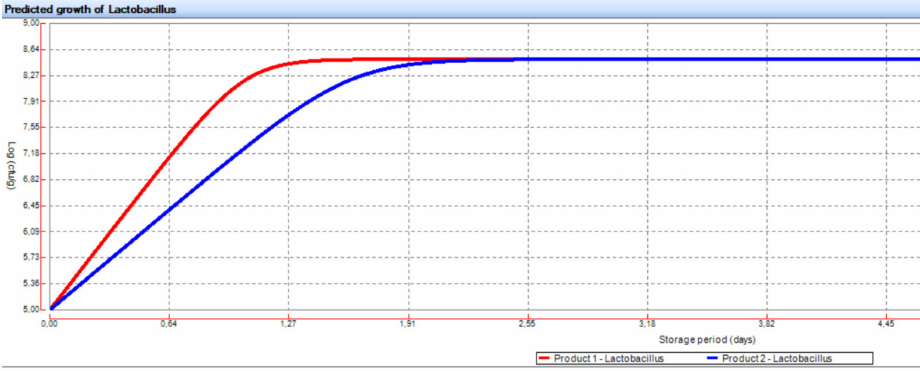
Figure 1. Example of growth curves (combinations S34 and S41) predicted for LAB using FSSP.